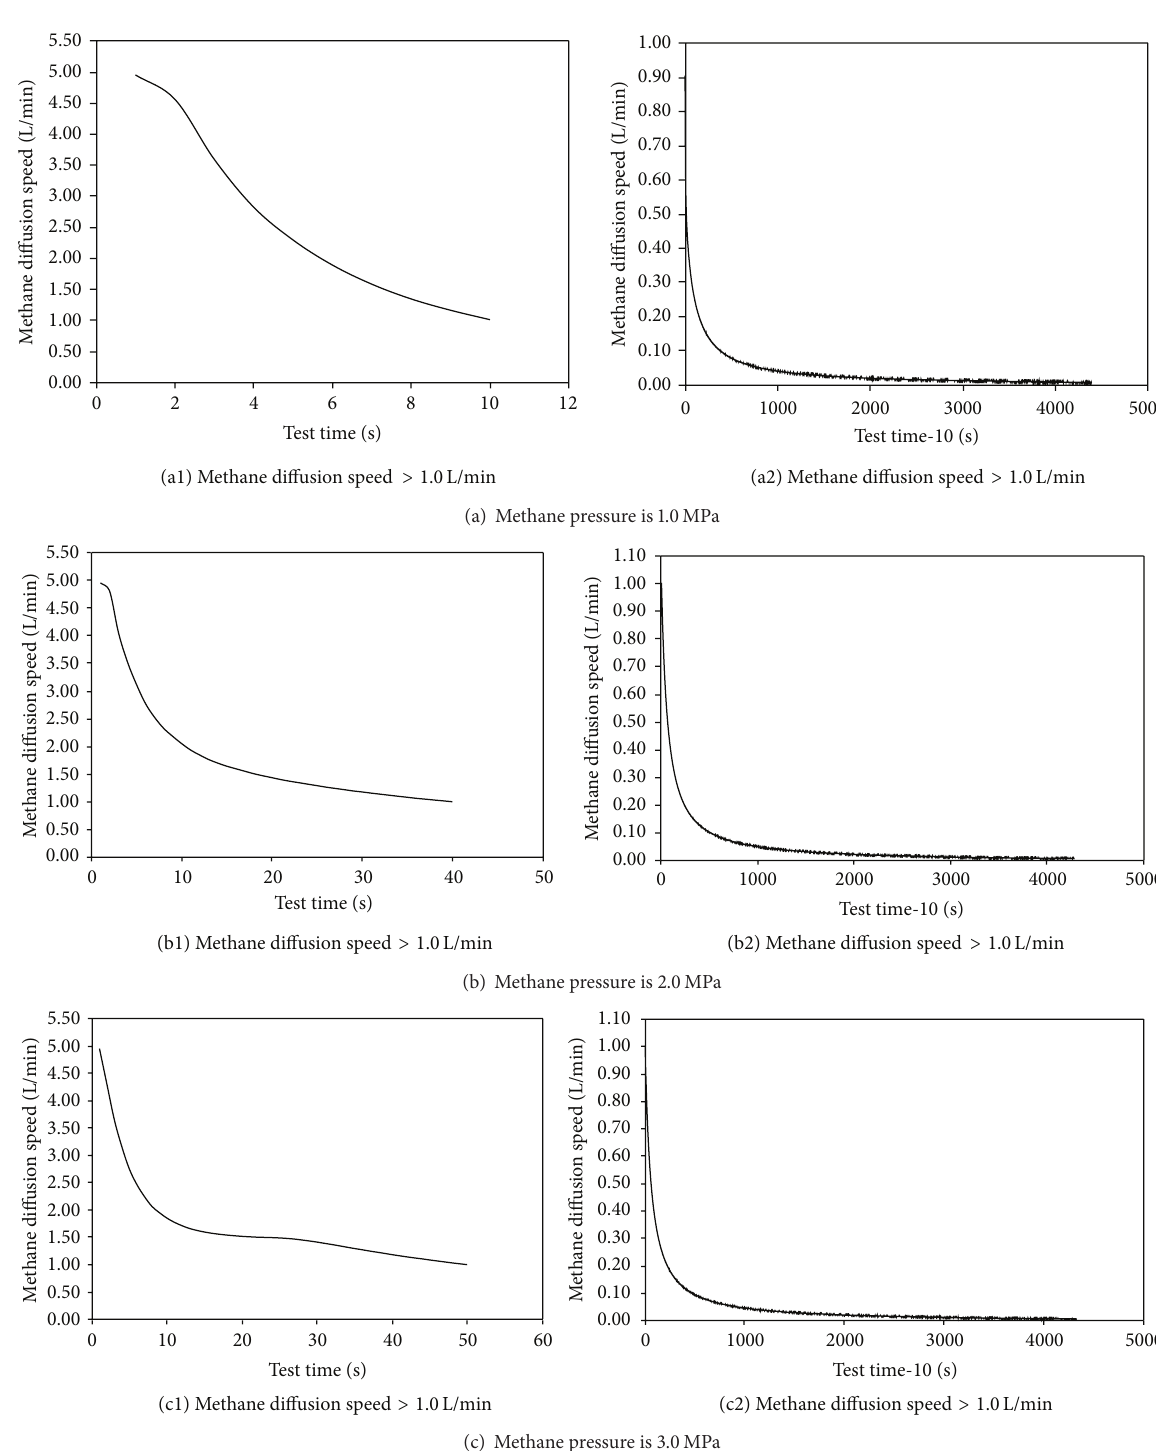
Figure 4: Influences of methane diffusion properties caused by methane